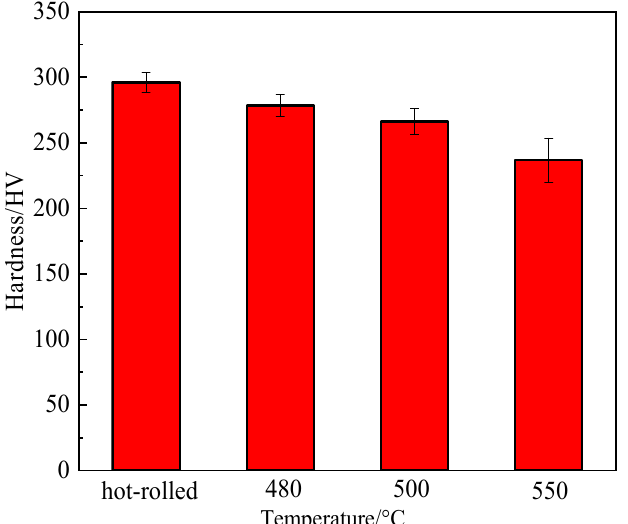
Figure 9. The microhardness of X70 steel after isothermal quenching at different temperatures .